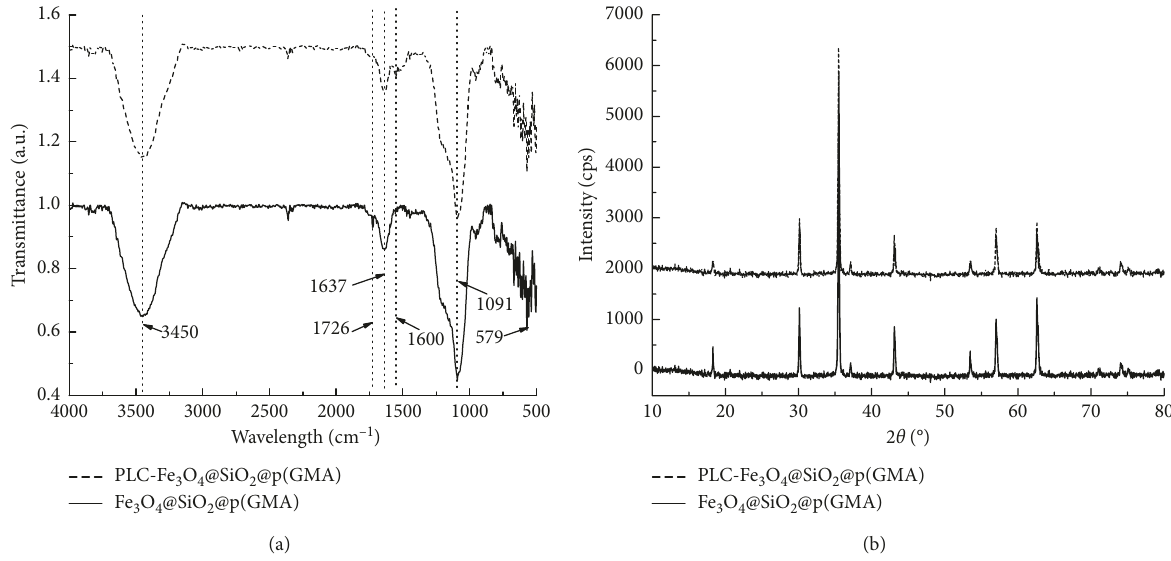
Figure 2: FT-IR spectrum analysis and XRD spectrum analysis. The FT-IR spectroscopy of Fe 3 O 4 @SiO 2 @p(GMA) and PLC-Fe 3 O 4 @SiO 2 @ p(GMA) had characteristic absorption peaks at 579cm − 1 , 1091cm − 1 , 1637cm − 1 , and 3450cm − 1 , respectively. The absorption peaks presented at near 1600cm − 1 belonged to ester groups of phospholipase in the FT-IR spectroscopy of PLC-Fe 3 O 4 @SiO 2 @p(GMA). The diffraction pattern of Fe 3 O 4 @SiO 2 @p(GMA) was close to PLC-Fe 3 O 4 @SiO 2 @p(GMA)’s that no phospholipase crystal peak was found in it, proving phospholipase well-dispersed on carrier. (a) FT-IR spectrum analysis. (b) XRD spectrum analysis.